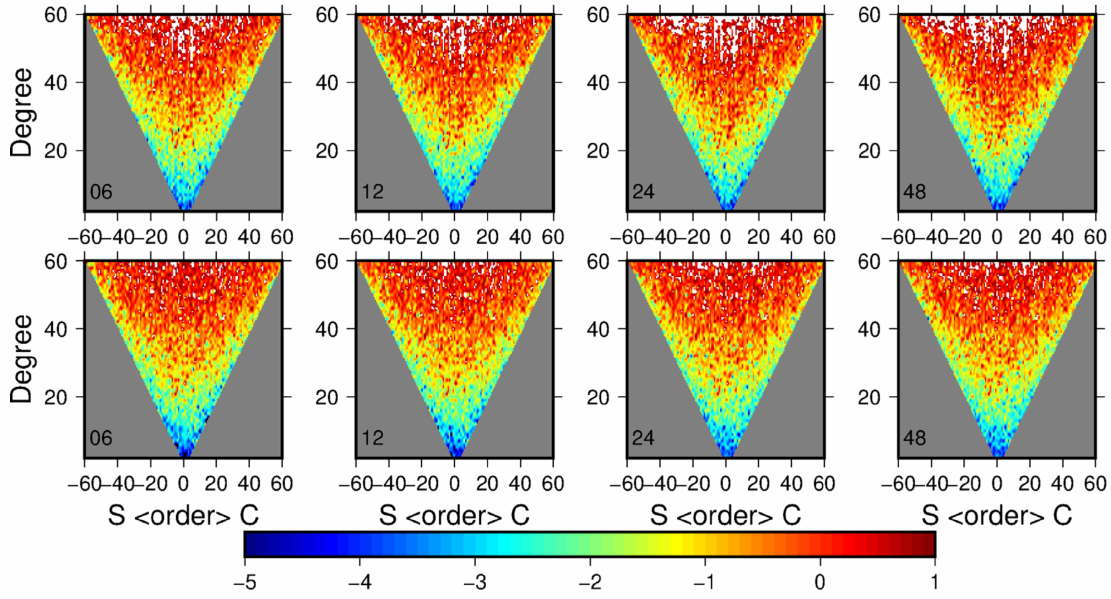
Figure 2. The logarithm of formal errors (comparing the EGM08) in the spherical harmonic coefficients of the recovered gravity field by using 6, 12, 24, and 48 h arcs, when using the orbit data to recover the gravity